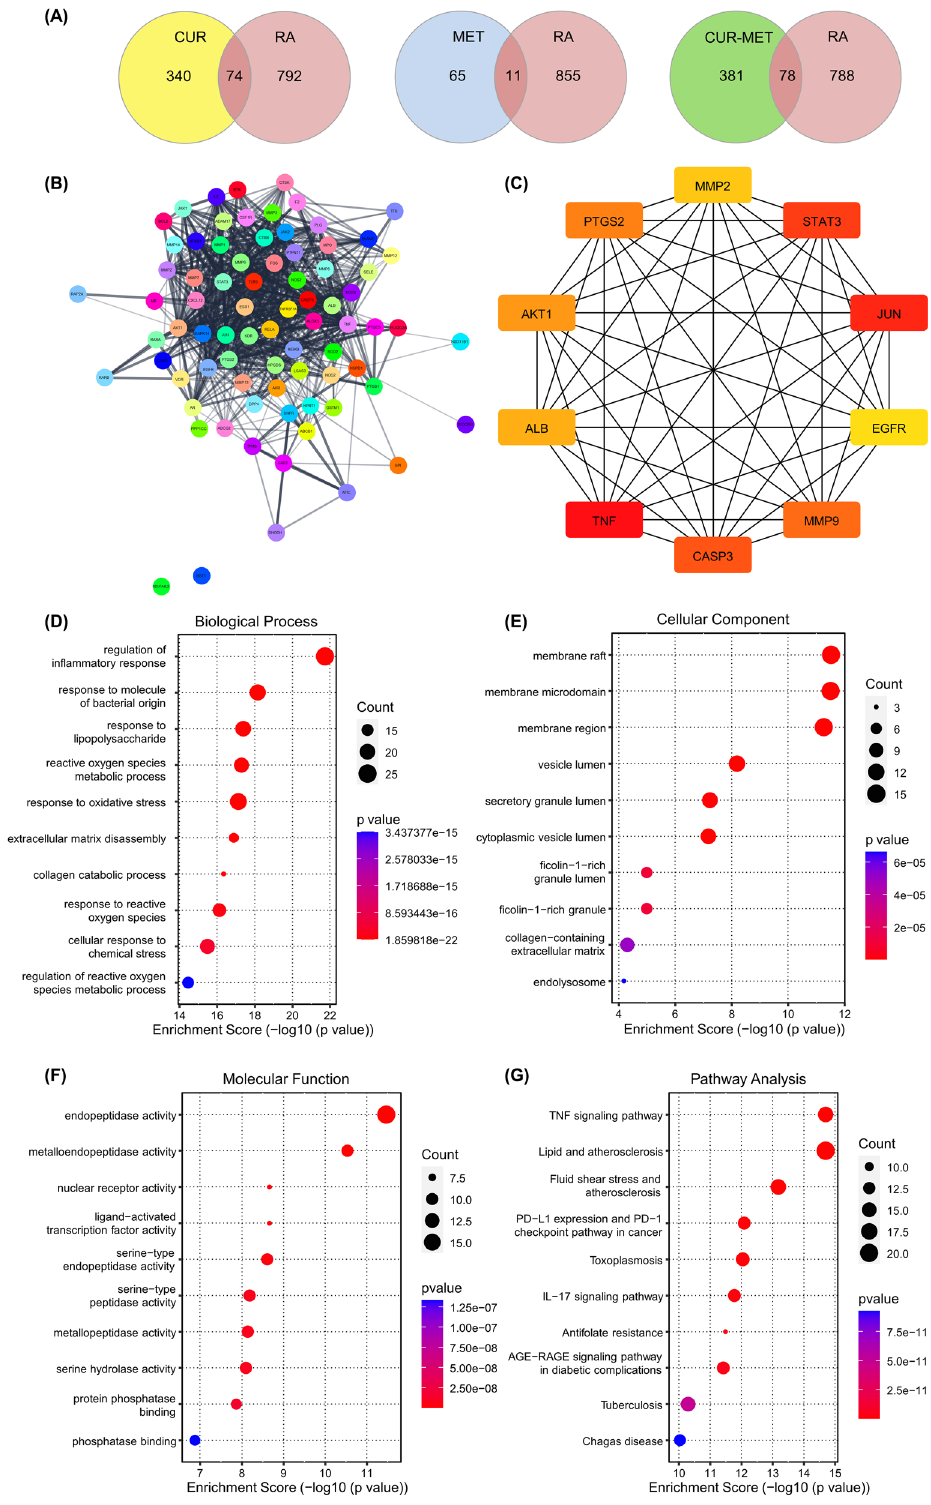
Figure 7. Network pharmacology analysis of underlying mechanisms of curcumin-metformin combination in inflammatory pain. ( A ) The intersection between the test compounds (curcumin, metformin, and curcumin- metformin combination) and rheumatoid arthritis-related targets. ( B ) Protein–protein interaction of 76 intersection genes ( B ) and the top 10 hub gene-network interactions ( C ). Gene ontology ( D–F ) and KEGG ( G ) enrichment pathway analyses. CUR curcumin, MET metformin, MET-CUR metformin-curcumin combination, GO Gene Ontology, KEGG Kyoto Encyclopedia of Genes and